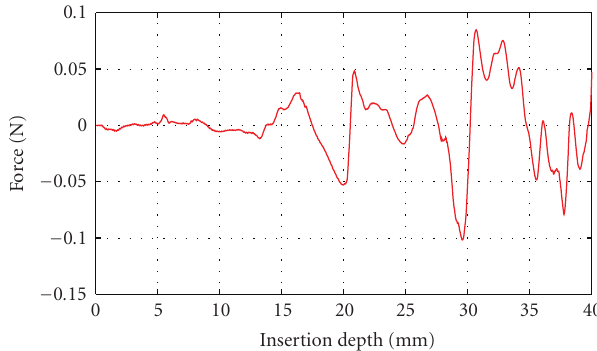
Figure 7: Insertion force prediction error.